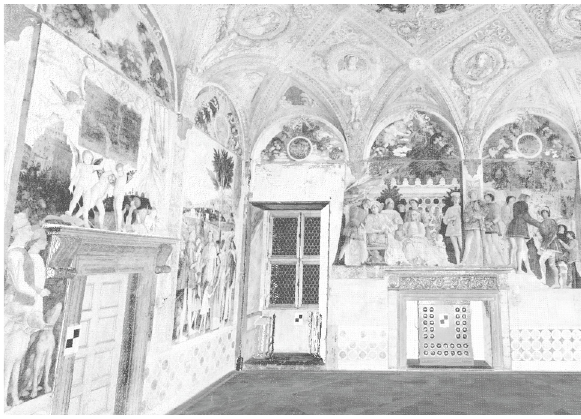
Figure 13. Point cloud of the Camera degli Sposi